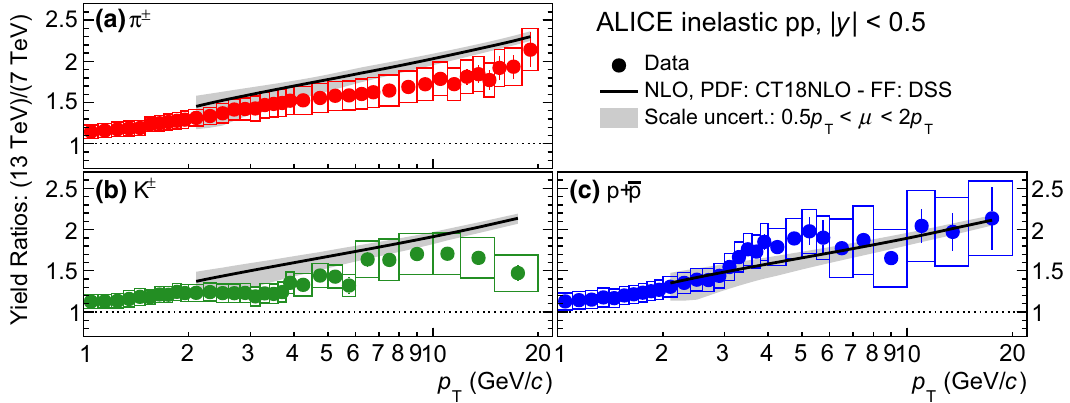
Fig. 18 Ratios of transverse-momentum spectra of π ± , K ± , and p ( p ) in minimum bias inelastic pp collisions at √ s = 7 TeV [25]. Solid lines show predictions from a next-to- at